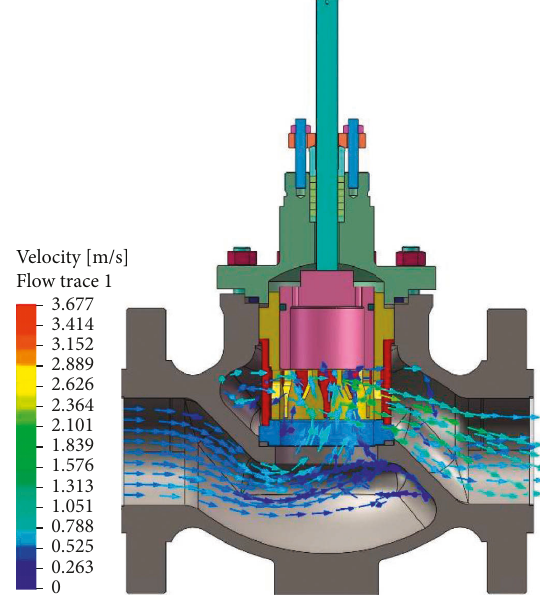
Figure 15: Flow trace diagram for 100% opening.